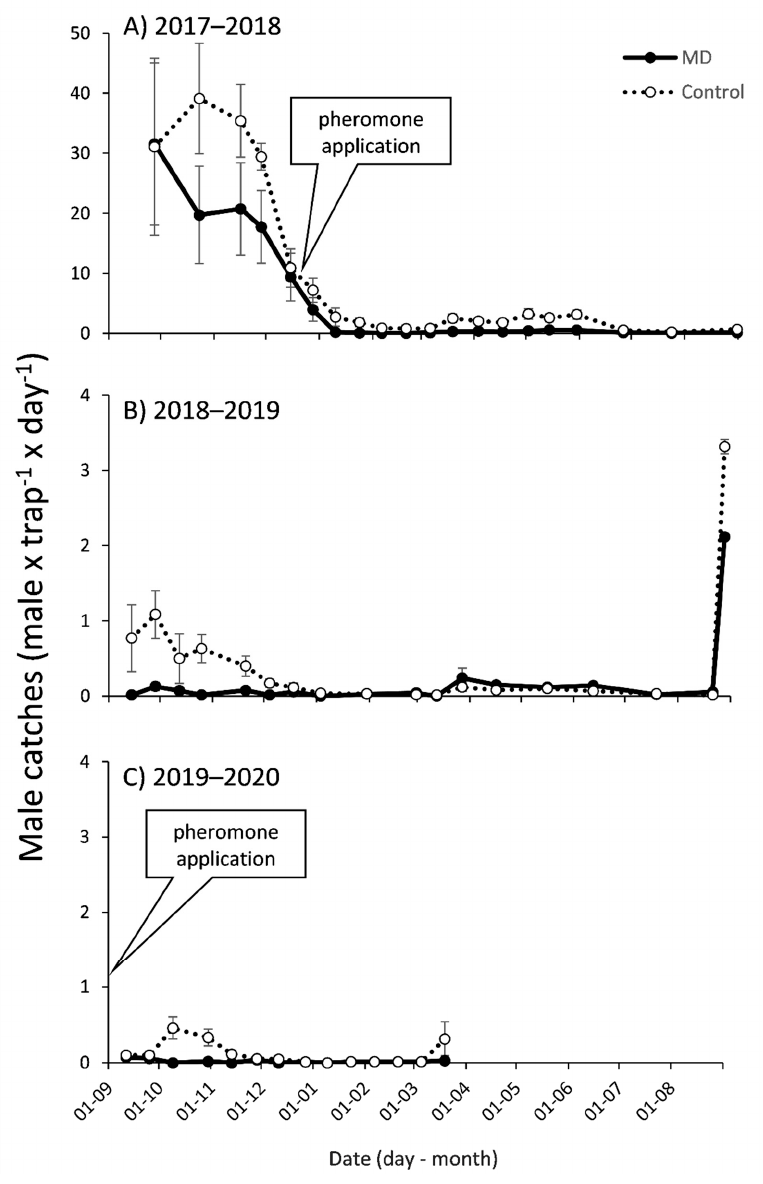
Figure 3. Season long adult male P. calceolariae (mean ± SEM) captures in pheromone baited traps in mating disruption (MD) and control plots in tangerine orchard from 1 September to 31 August of ( A ) 2017–2018, ( B ) 2018–2019 and ( C ) 2019– 2017 and 2 September 2019. Note that the scale for the Y axis in the first season differs from the